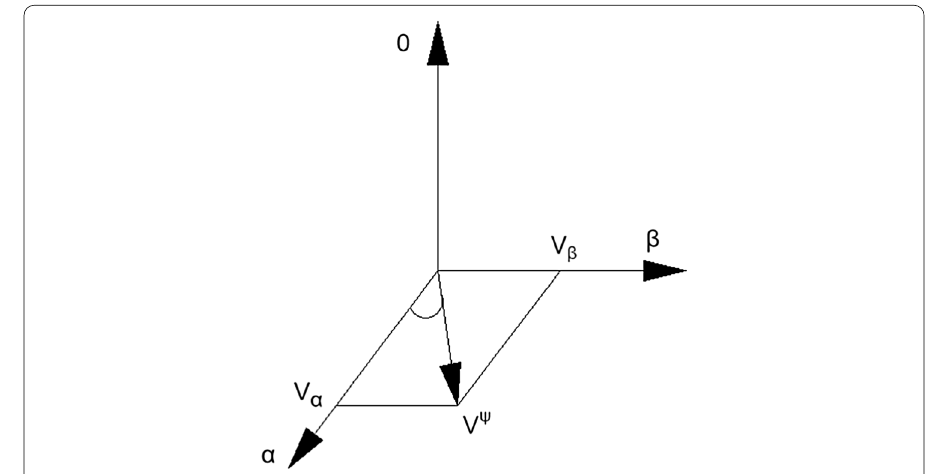
Fig. 1 The distribution of